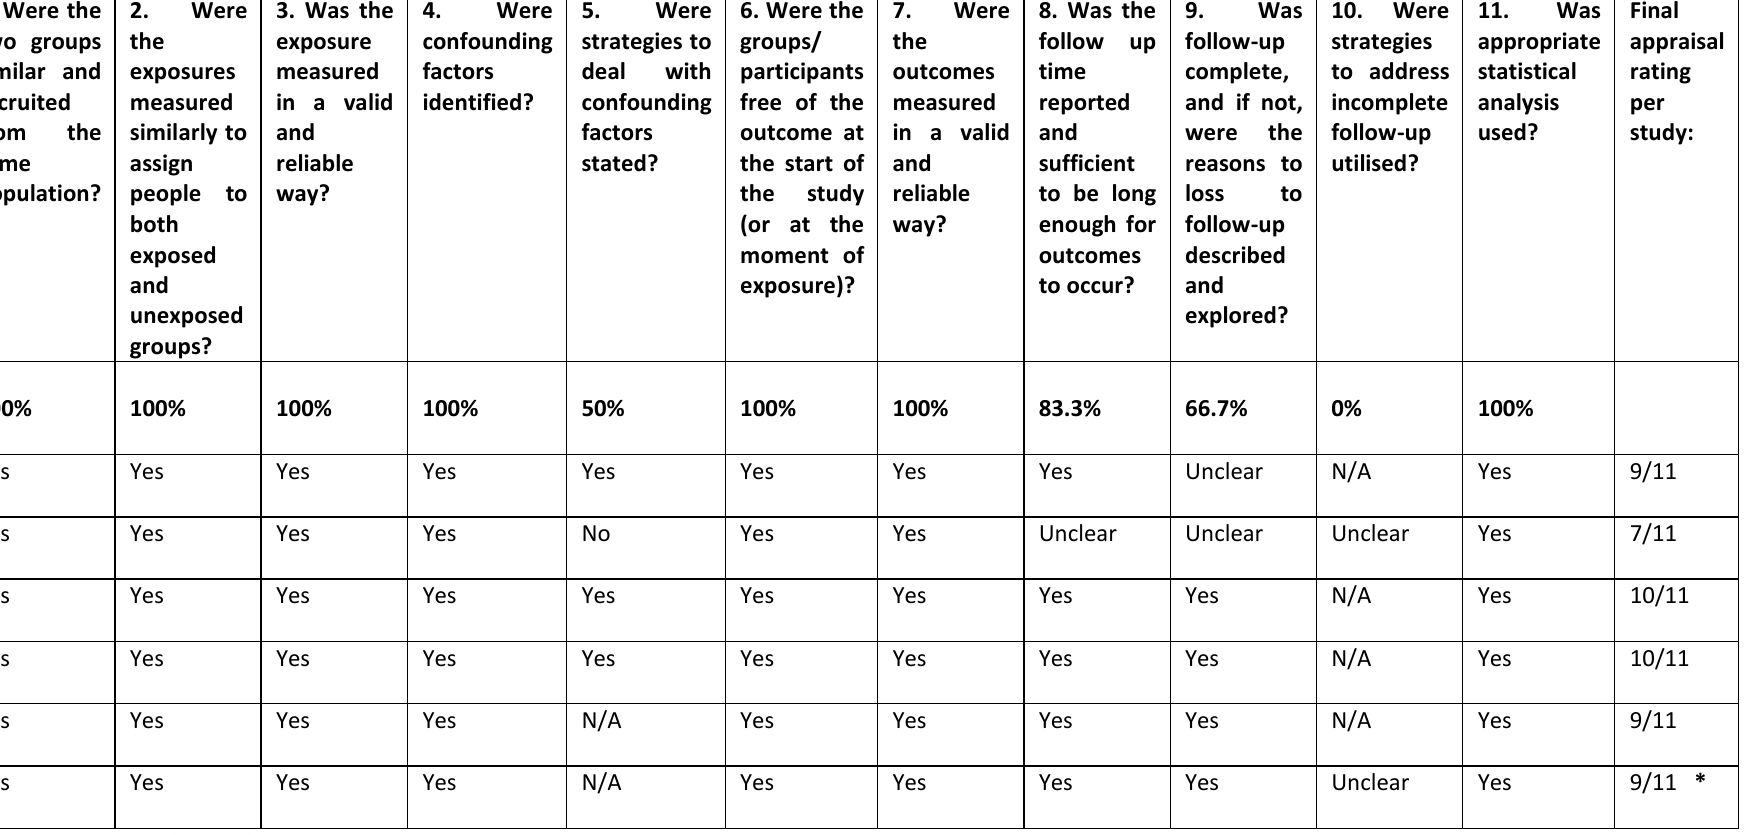
TABLE 4-A1: Cohort study detailed critical